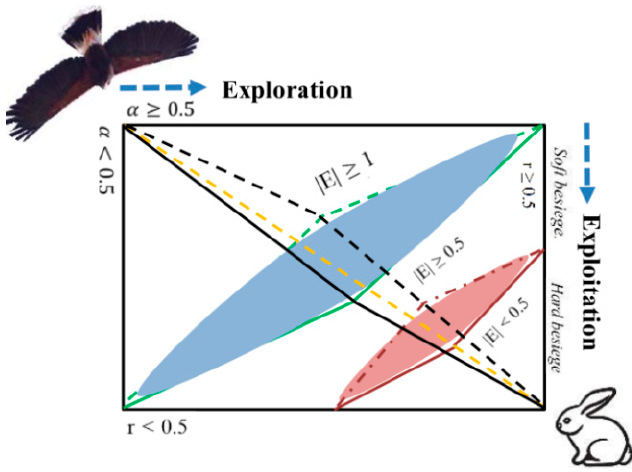
ff erent steps of the multi-objective Harris hawks optimization (MOHHO) technique Figure 9. Different steps of the multi-objective Harris hawks optimization (MOHHO) technique [48]. Figure 9. Di